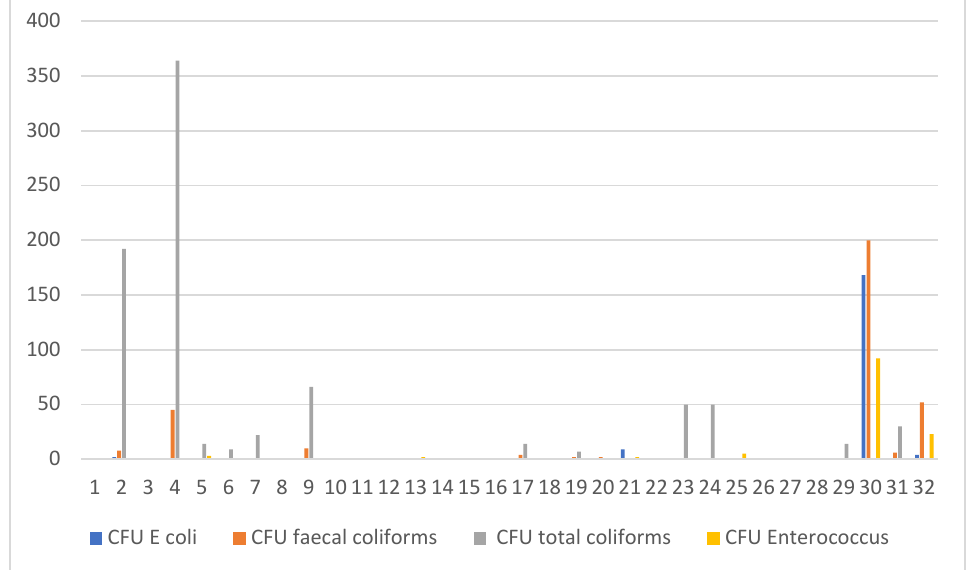
(Figure 2). No Salmonella sp. were recorded.